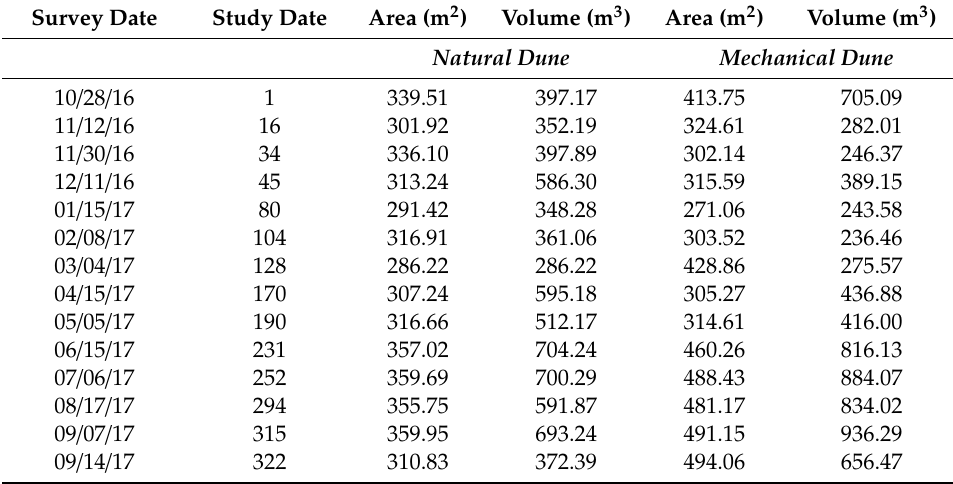
Table 2. Area (m 2 ) and volumes (m 3 ) for the natural and mechanical dune. The dune area was delineated on 10 / 28 / 16 and held constant throughout the study